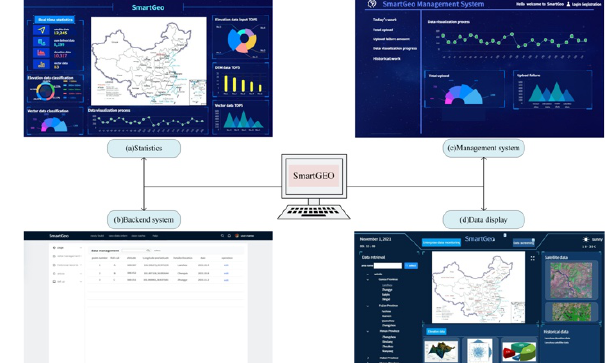
Figure 3 . Platform logo.